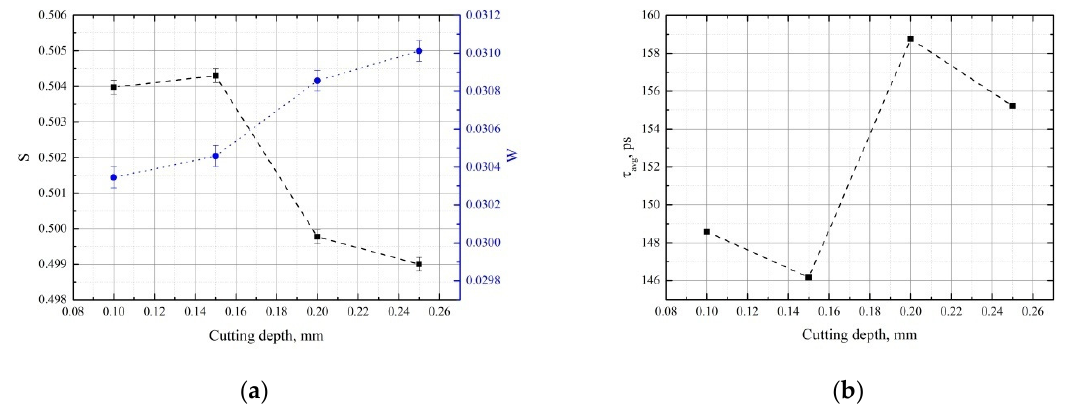
Figure 7. Trends in S (black) and W (blue) parameters ( a ) and average positron lifetime ( b ) as a function of cutting depth for GCr15 steel.